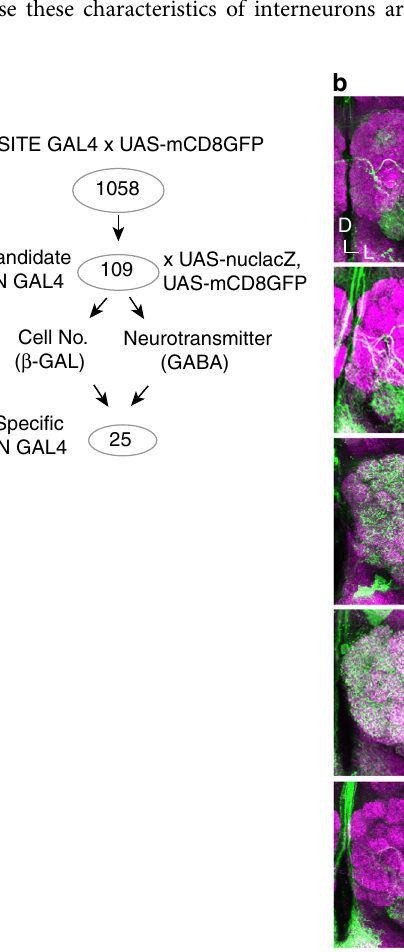
Fig. 1 Genetic screen for GAL4 drivers that label distinct subtypes of LNs. a An overview of the LN GAL4 screen is shown. b Projected confocal images show labeled LNs of 25 identi fi ed LN GAL4 lines. Adult brains were stained with neuropil markers Bruchpilot (magenta). LNs were visualized by GAL4- driven mCD8GFP (green). The scale bar in this and all fi gures (unless otherwise indicated) is 20 μ m. All ALs are oriented such that the midline is in the left. D: dorsal, L: